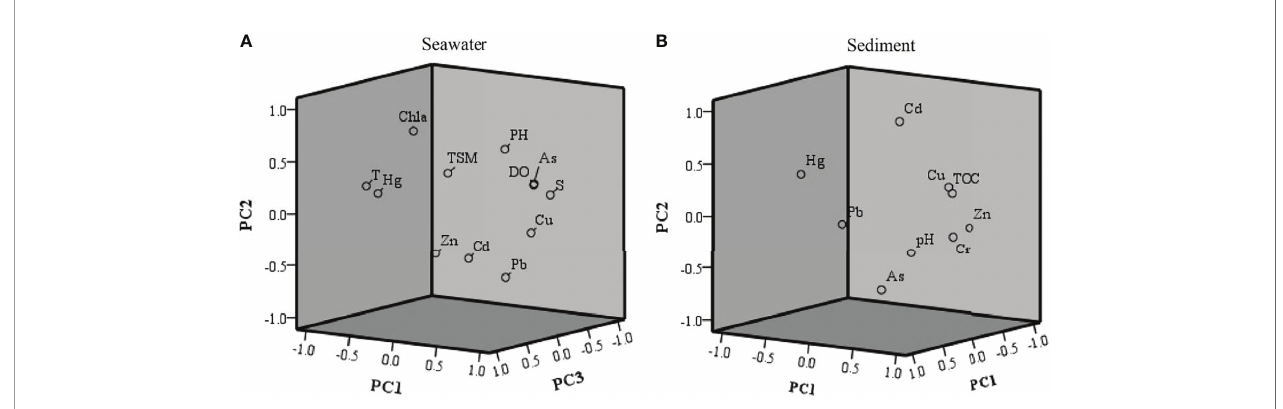
FIGURE 7 | Results of principal component analysis of heavy metal concentrations and environmental parameters in the estuary and the adjacent mariculture in Qinzhou